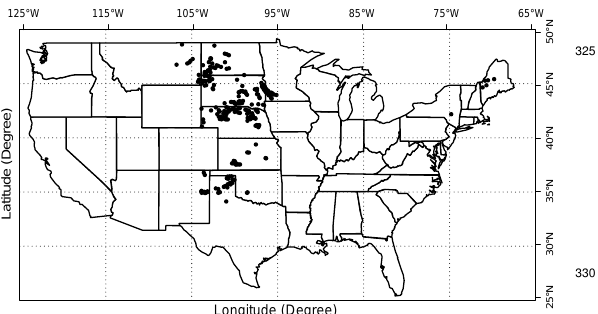
Figure 10. The geographic locations, denoted by filled circles, where wind speed data were analysed for performance of deterministic model prediction.